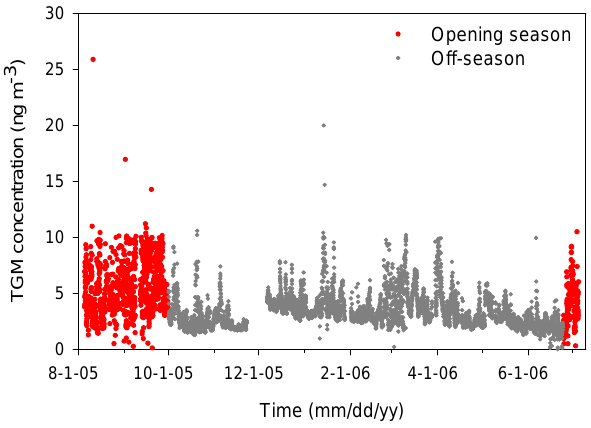
Fig. 5. Time series of hourly mean TGM concentrations at S2 from August 2005 to July